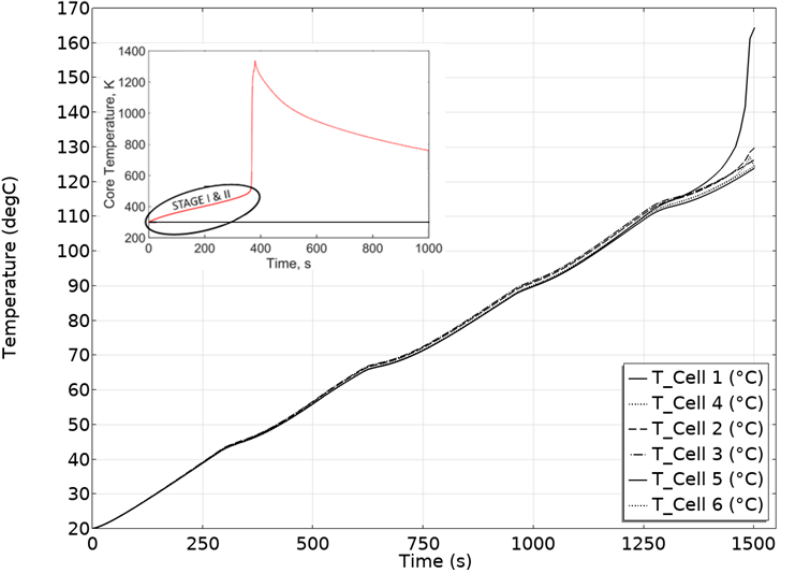
Figure 11. Temperature vs. time prediction; the model includes the TR kinetic. The inset picture reproduces the experimental temperature trend when TR is incipient, adapted from [34].